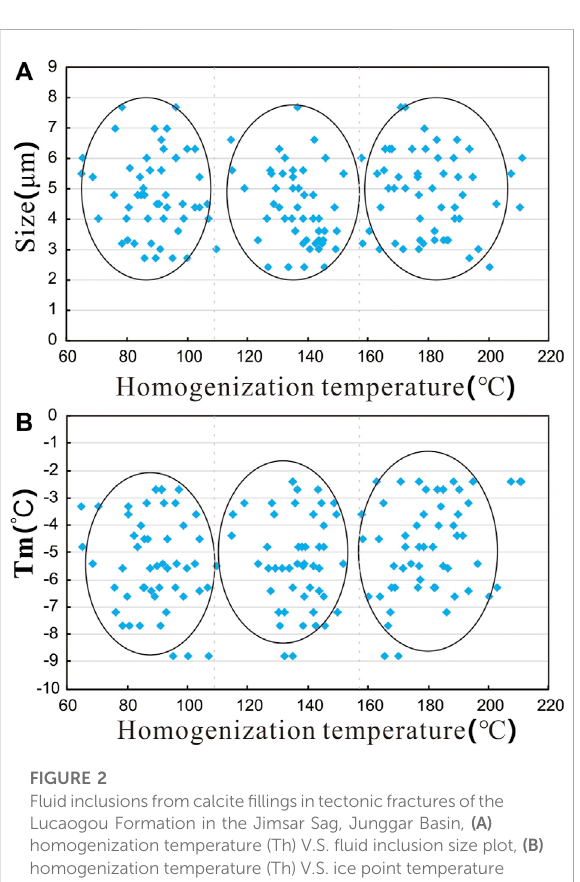
FIGURE 2 Fluidinclusionsfromcalcite fi llingsintectonicfracturesofthe Lucaogou Formation in the Jimsar Sag, Junggar Basin, (A) homogenization temperature (Th) V.S. fl uid inclusion size plot, (B) homogenization temperature (Th) V.S. ice point temperature (Tm) plot.